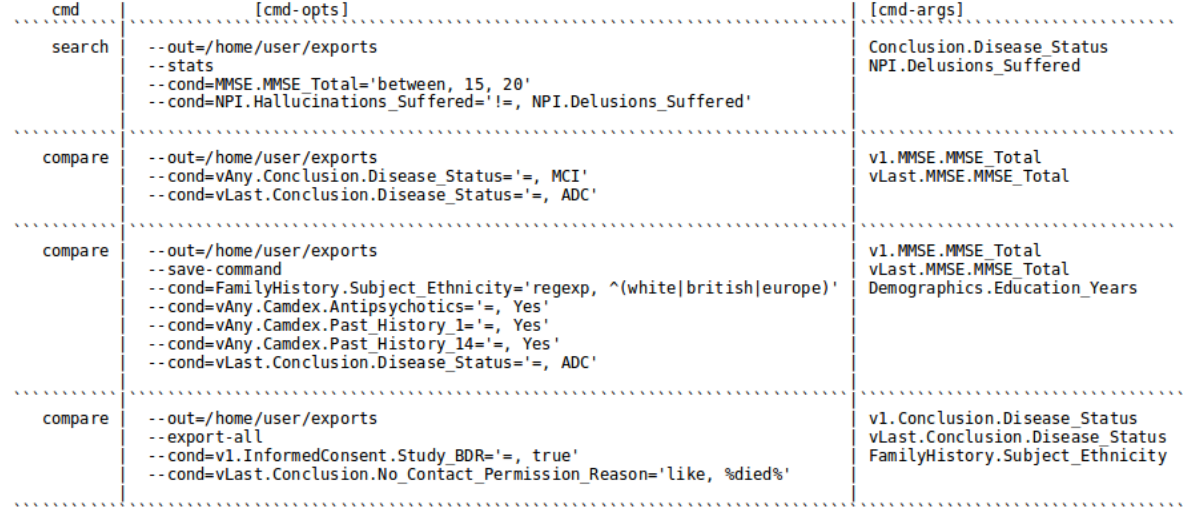
Figure 4. CohortExplorer commands for the Alzheimer's and Dementia datasource. For better understanding the commands are divided into their respective components namely; command name, command options and command